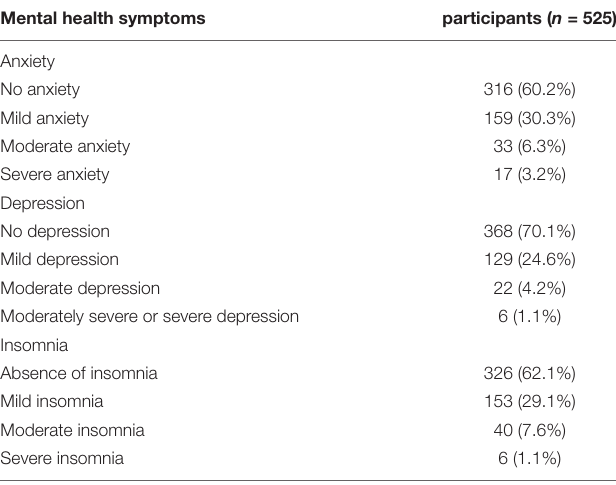
TABLE 2 | The prevalence of mental health symptoms in frontline medical